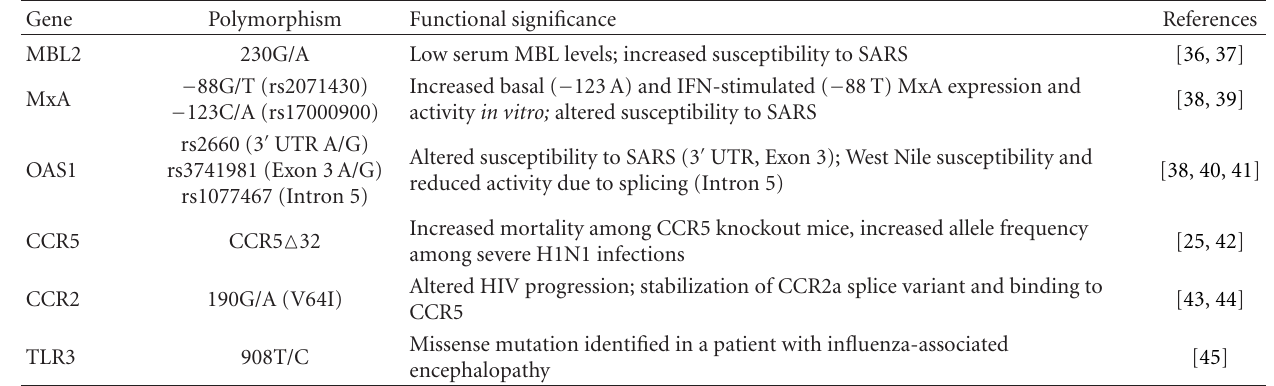
Table 2: Genetic polymorphisms of interest in H5N1 susceptibility and